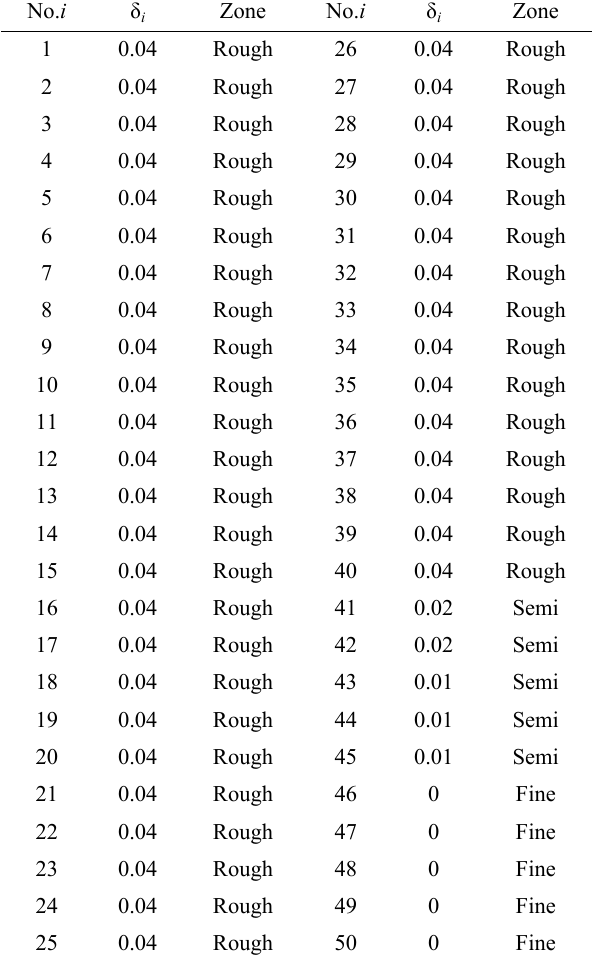
Table 1 Rise per tooth in different zone on broach.